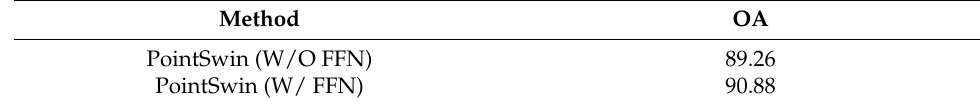
Table 6. The OA results of group